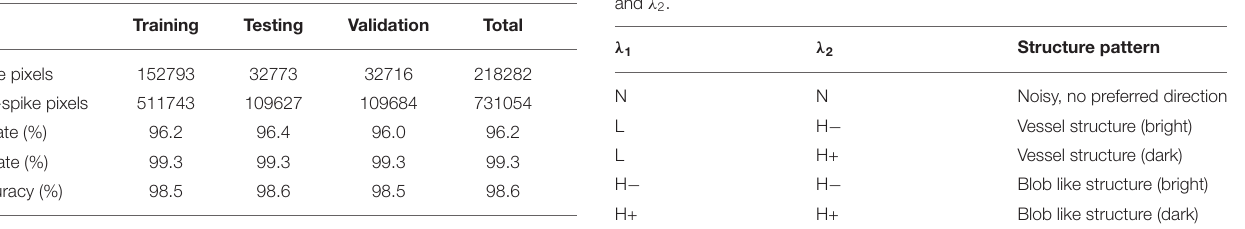
TABLE 1 | Statistical performance of the neural network in the training stage. TABLE 2 | Possible structural patterns in 2D images depending on eigenvalues λ 1